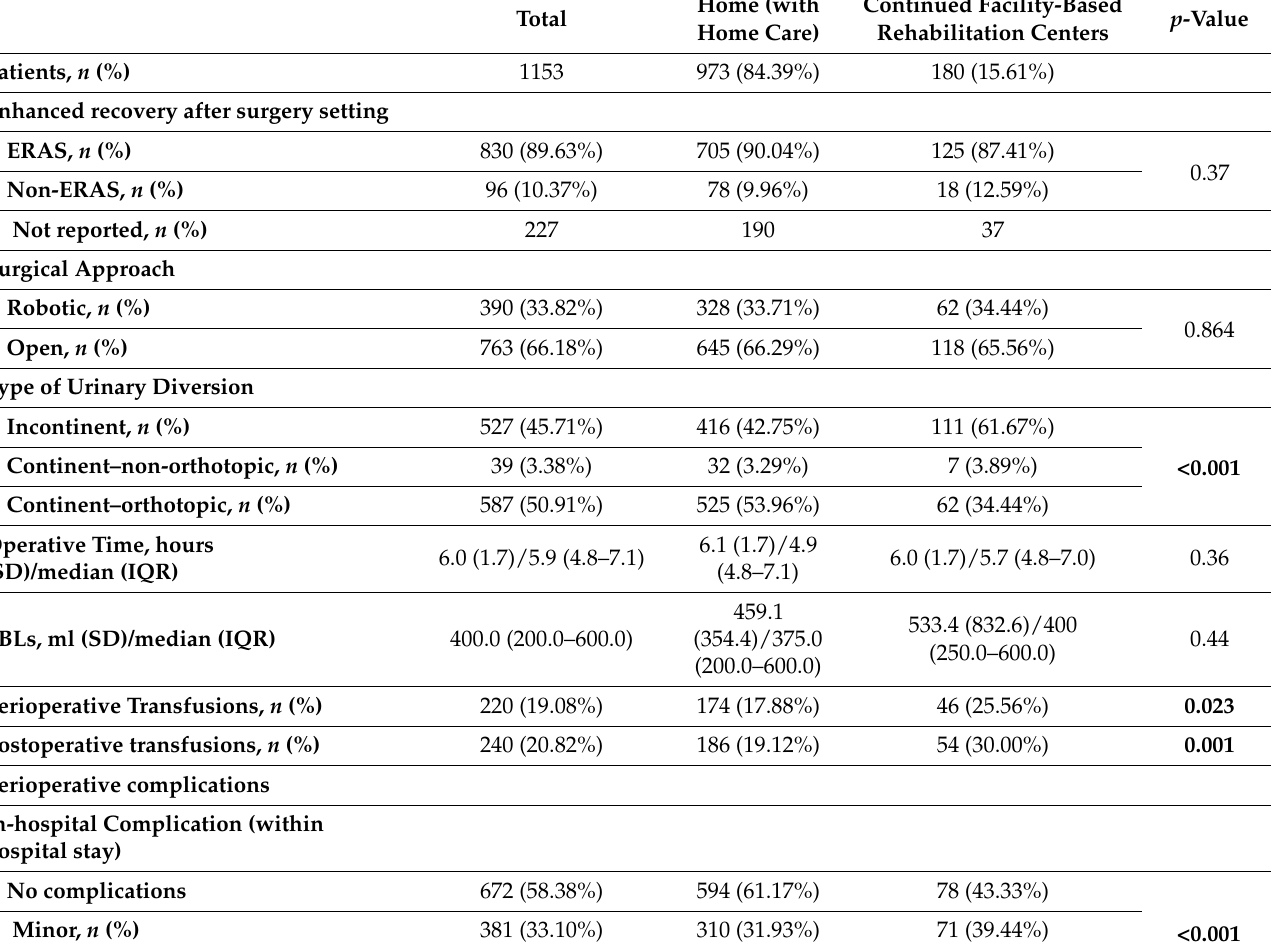
Table 2. Surgical and Perioperative outcomes.